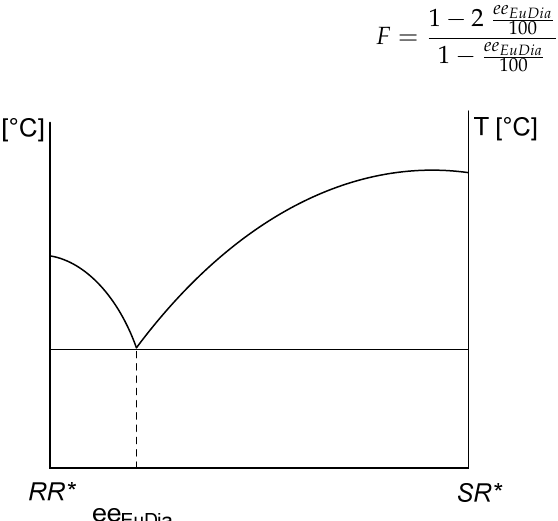
Figure 2. Binary melting phase diagram of a diastereomeric mixture of RR * and SR * [3,6] and the possibility of calculating the achievable F value using the ee Dia (Equation (2)).